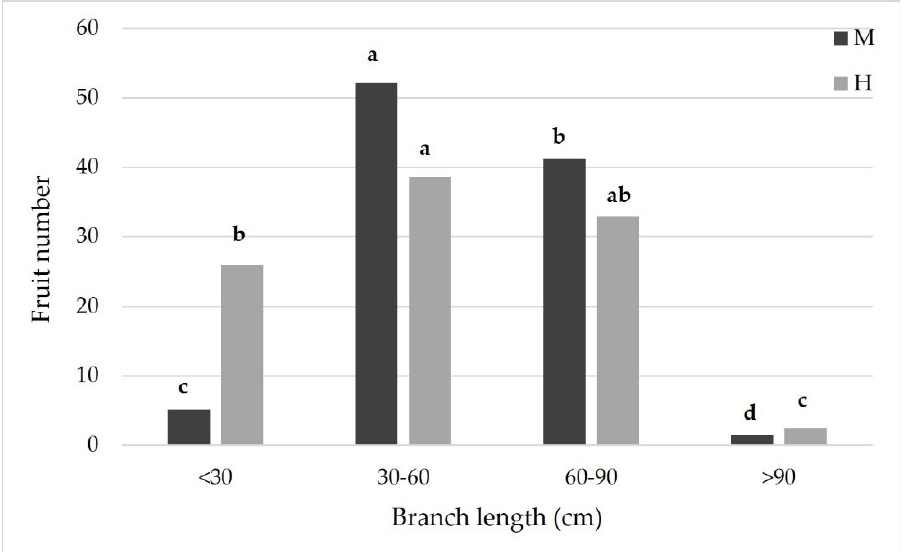
Figure 2. Number of fruits detached mechanically (M) and manually (H), according to branch length. Means followed by the same letter do not differ significantly at p ≤ 0.05 according to Duncan test. Statistical comparisons were carried out within each thinning technique. Agriculture 2021 , 11 , 1138